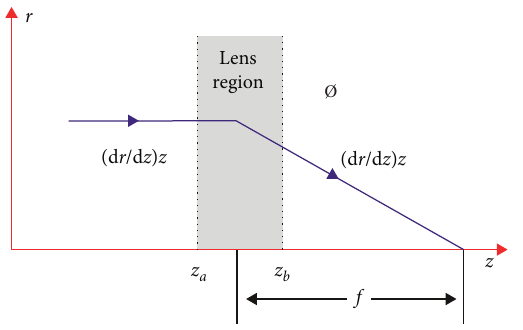
Figure 2: Diagram of the ion optic